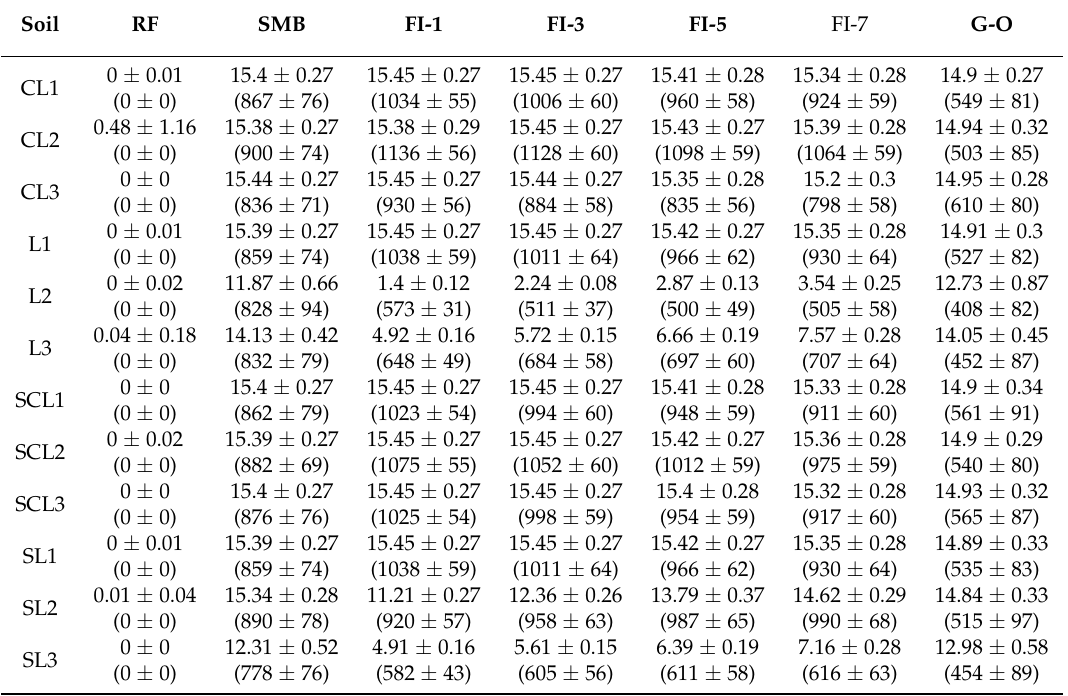
Table A1. Dry yield (in t ha − 1 ) and water use (in mm) for maize, as a function of soil type according to irrigation strategy, as a mean value of simulated values from 1965 to 2016. Values outside and inside parentheses indicate dry yield and water use,